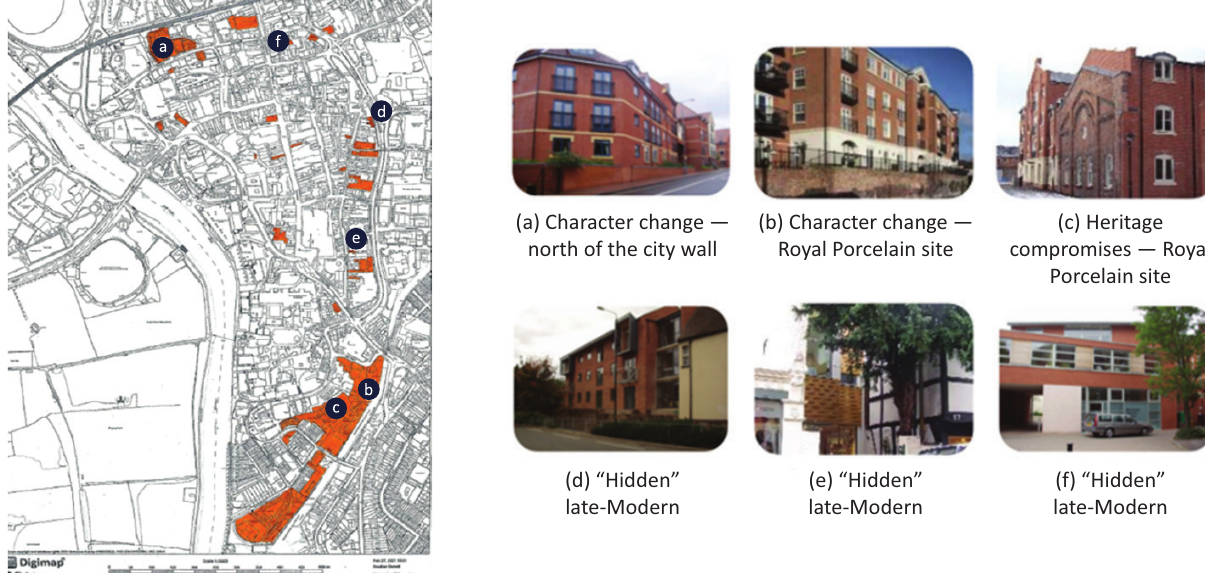
Figure 6. The location of new build development proposals between 1998–2007: Change at extra‐mural edges and “hidden’’ late‐Modernism. Base‐map on the left by Digimap and on the right annotations and photos by the